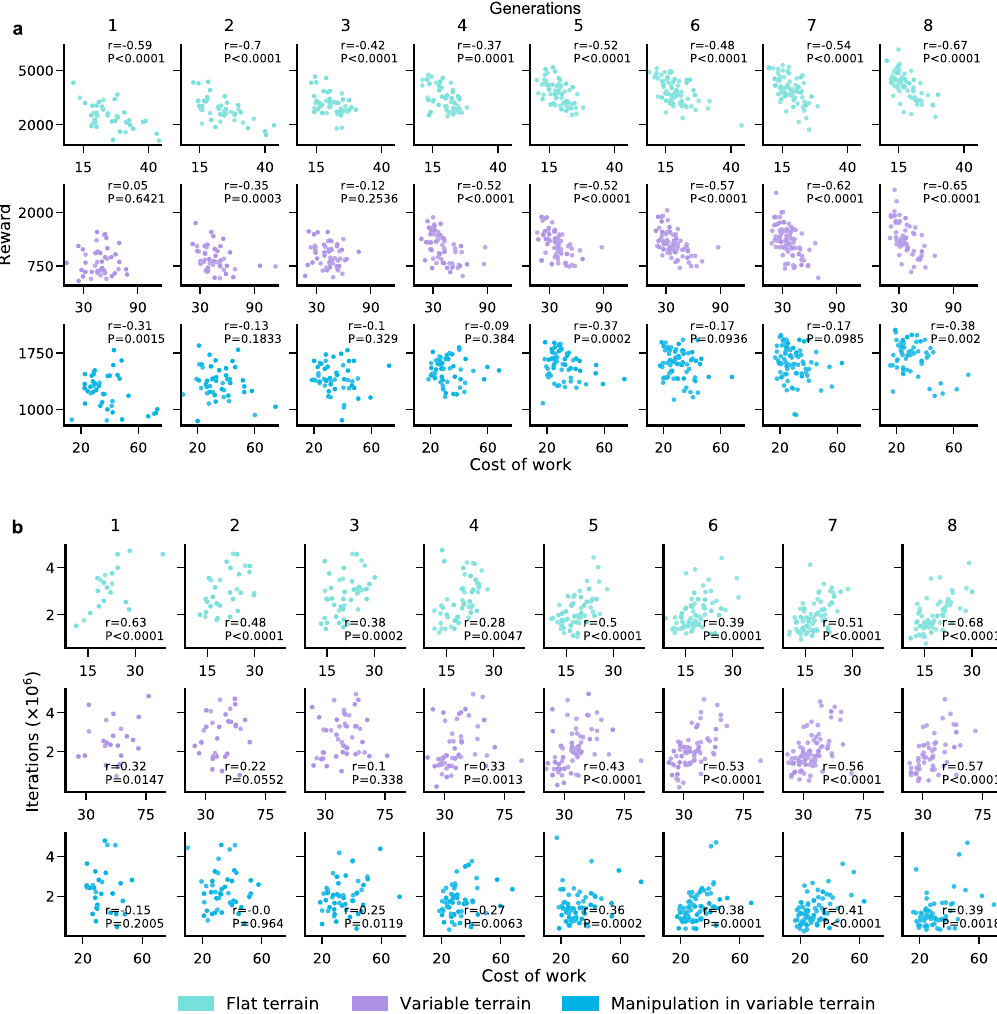
Fig. 5 Relationship between energy ef fi ciency, fi tness, and learning speed. a Correlation between fi tness (reward at the end of lifetime learning) and cost of work for the top 100 agents across 3 evolutionary runs. b Correlation between learning speed (iterations required to achieve the 75th percentile fi tness of the initial population same as Fig. 4a) and cost of work for same top 100 agents as in ( a ). Across all generations, morphologies which are more energy- ef fi cient perform better (negative correlation) and learn faster (positive correlation). a , b Shown are the correlation coef fi cients ( r ) and P values obtained from two-tailed Pearson ’ s